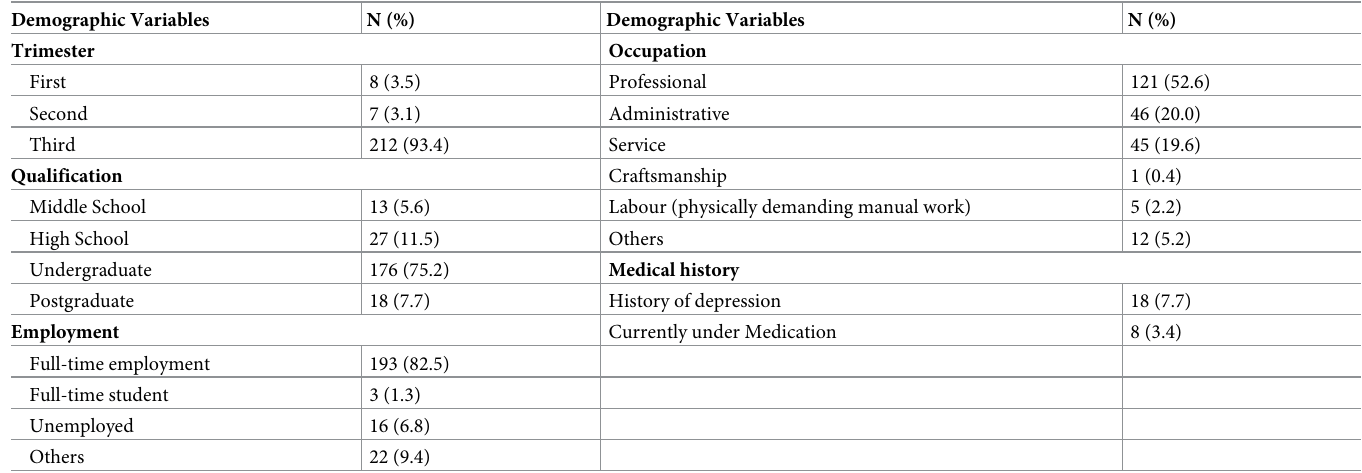
Table 1. Descriptive statistics of pregnant sample.